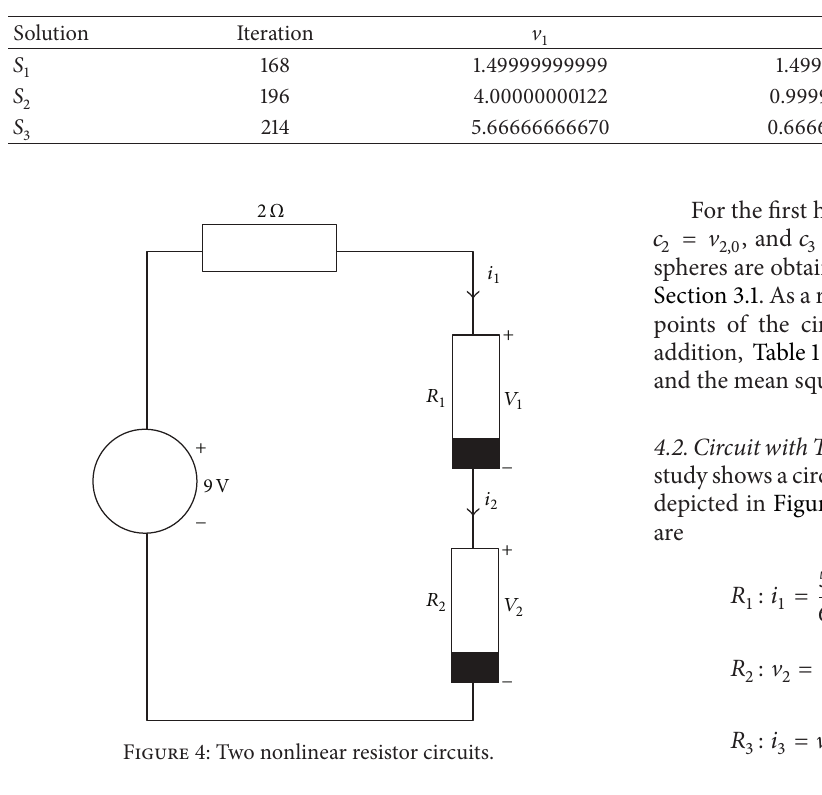
Table 1: Numerical solutions for (12).